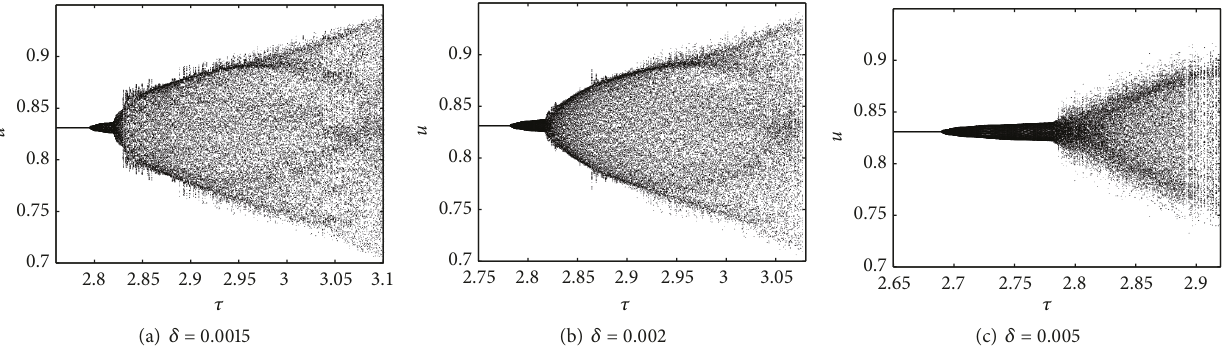
Figure 14: Neimark-Sacker bifurcation diagram of the coupled dynamical network with different coupling strengths. Globally coupled network is applied, 𝑁 = 20 . Other parametric conditions are the same with Figure